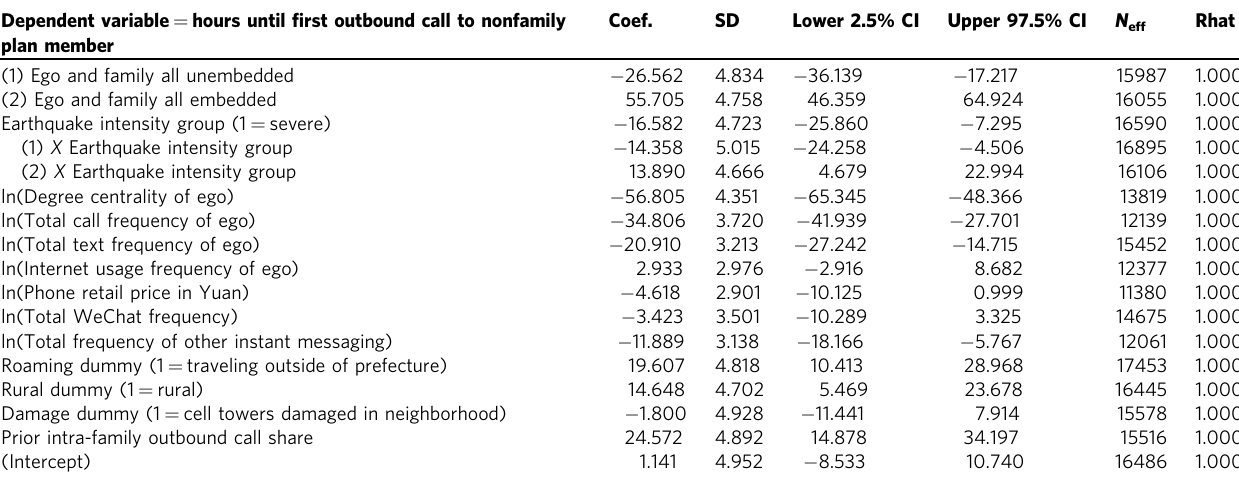
Table 2 Latency until fi rst outbound call to a nonfamily plan